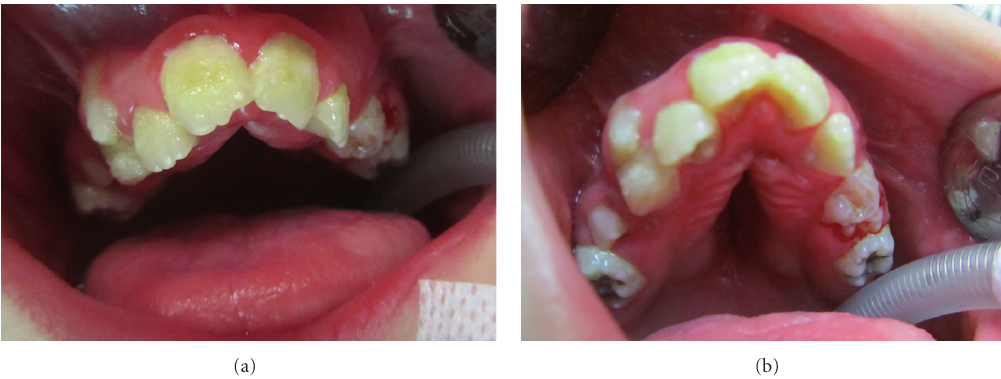
Figure 3: (a) Intraoral findings were a small mouth and malocclusion. (b) In intra-oral findings, high-arched and cleft palate was seen. And upper molar teeth had deep dentinal carious lesions.